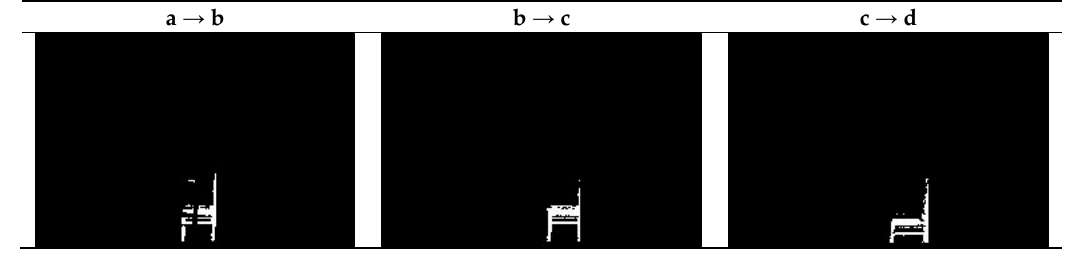
Figure 8. The detected foreground objects.